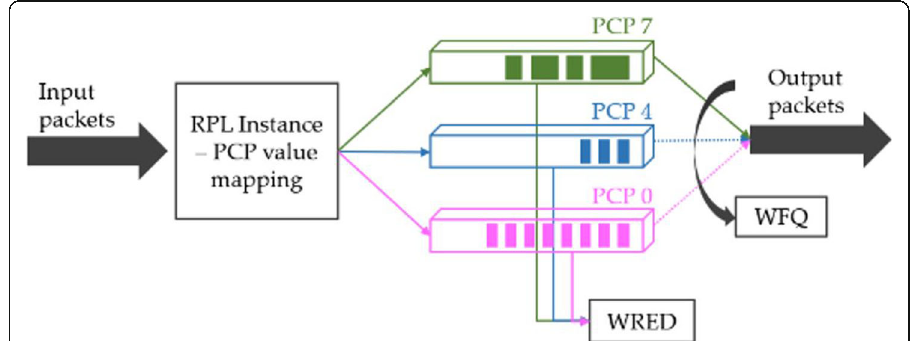
Fig. 5 NVIS gateway QoS mechanism. Definition of the mechanism used to apply QoS to the different services of the